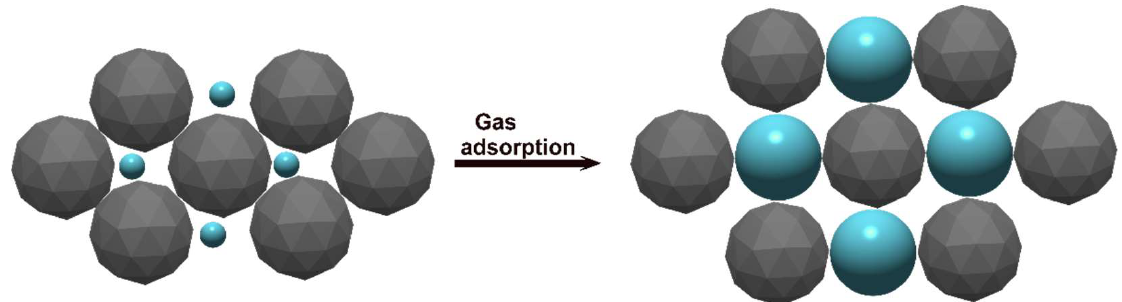
Figure 4. Results of Deng’s selectivity studies in analysis of a porogen imprinted polymer for o -xylene. MIPs were produced using divinylbenzene as functional monomer and crosslinker, and o -xylene was used as template and solvent. The resulting monolith was ground, dispersed in o -xylene and cast onto a quartz crystal to give a gravimetric sensor. Reproduced with permission [131].